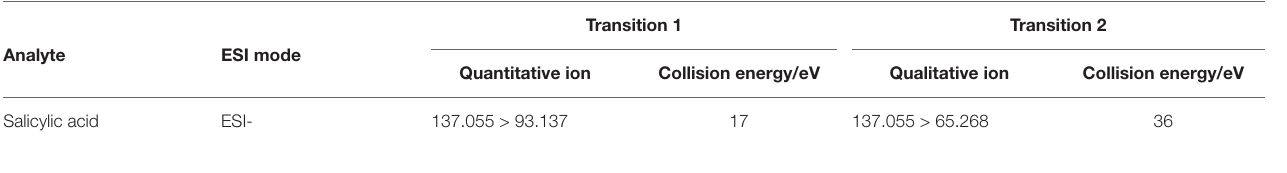
TABLE 1 | Characteristic fragment ions of the salicylic acid (SA) obtained by liquid chromatography-mass spectrometry (LC-MS) in selective response monitoring (SRM) mode.